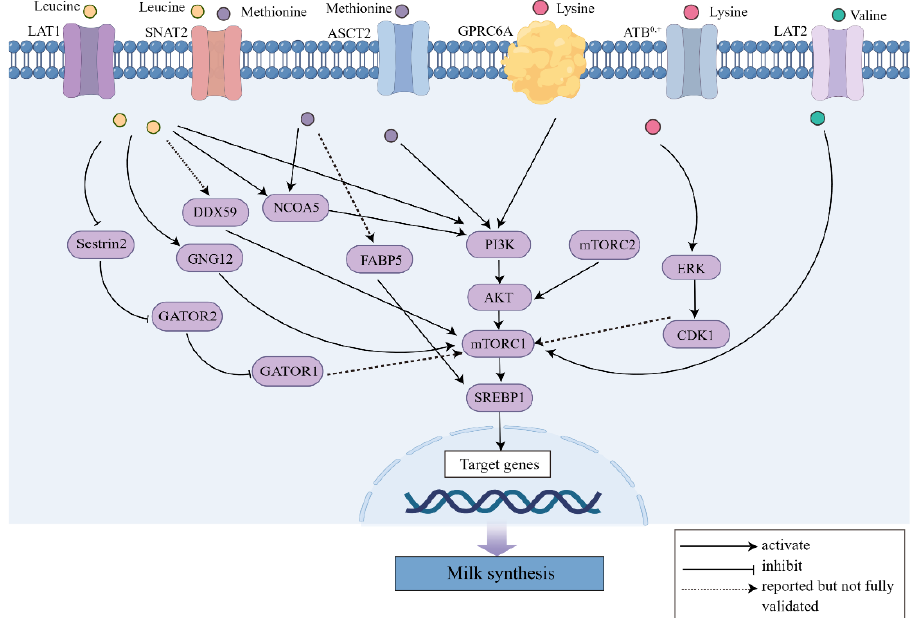
Figure 1. The regulation of milk synthesis by methionine, leucine, valine and lysine. The amino acids were transport across membrance by different transportors including LAT1, LAT2, SNAT2, ASCT2, and ATB 0,+ , respectively. GPRC6A: G protein-coupled receptor class C group 6 member A, is a basic amino acid receptor. The mammalian target of rapamycin complex 1 (mTORC1) is the most important regulator of these pathways. The activation of mTORC1 increases milk protein synthesis and regulates milk fat synthesis.